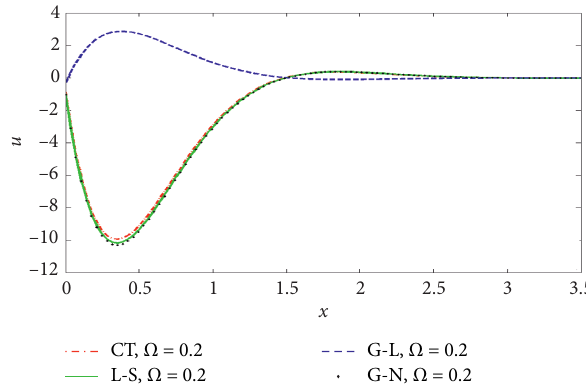
Figure 2: Horizontal displacement u concerning x under four thermoelastic theories.